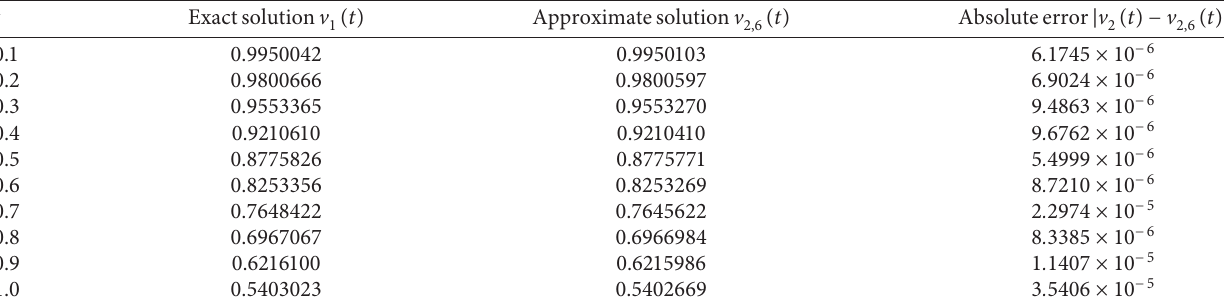
( t ) and approximate v ( t ) solutions for Example 2 at β � 1 and k � 6 over the interval [0, 1]. 2 2 , 6